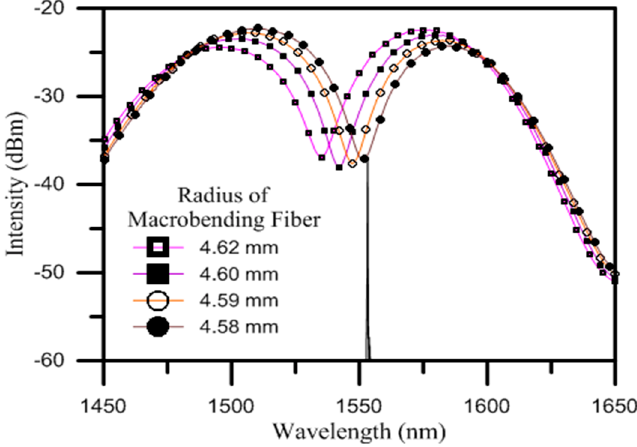
Figure 5. The interference spectra of WGM edge filter corresponding to the resonant wavelength peak of the fiber Bragg grating (FBG) sensor.